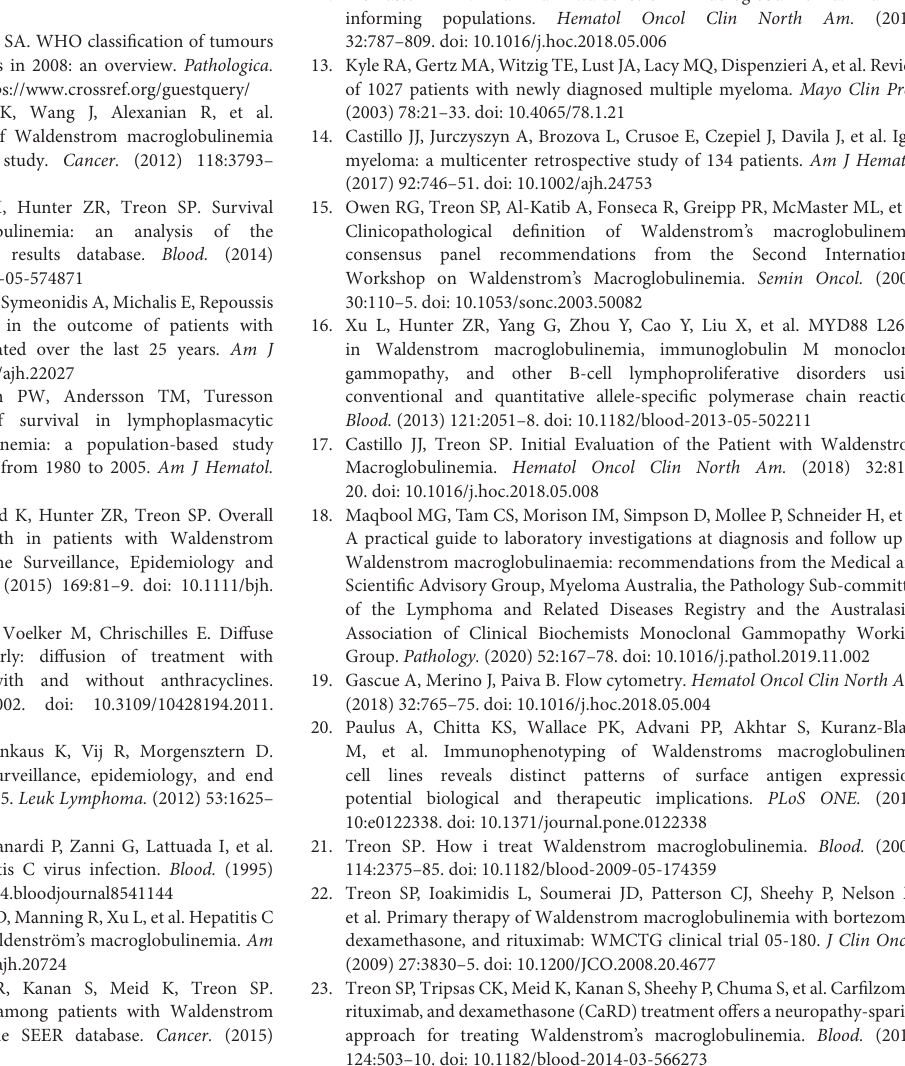
Supplementary Figure 2 | Trends in the annual incidence-based mortality of Waldenström macroglobulinemia in patients stratified according to the primary site of involvement. Supplementary Figure 3 | Trends in the annual incidence of Waldenström macroglobulinemia in patients stratified according to the geographical region. Supplementary Figure 4 | Trends in the annual incidence-based mortality of Waldenström macroglobulinemia in patients stratified according to the geographical region. Supplementary Figure 5 | Trends in the annual incidence of Waldenström macroglobulinemia in patients stratified according to the subtype recode. Supplementary Figure 6 | Trends in the annual incidence-based mortality of Waldenström macroglobulinemia in patients stratified according to the subtype recode. Supplementary Figure 7 | Kaplan–Meier analysis for Waldenström macroglobulinemia in patients stratified according to the era in which the diagnosis was